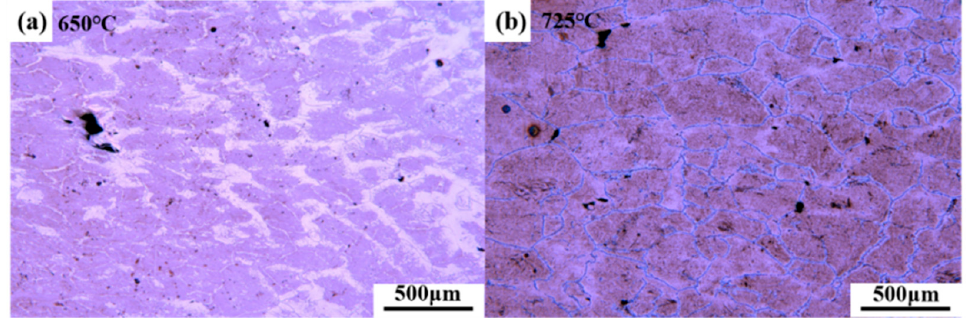
Figure 5. Microstructure of tensile specimen. ( a ) Microstructure of 650 °C tensile specimen; ( b ) Microstructure of 650 °C tensile specimen.